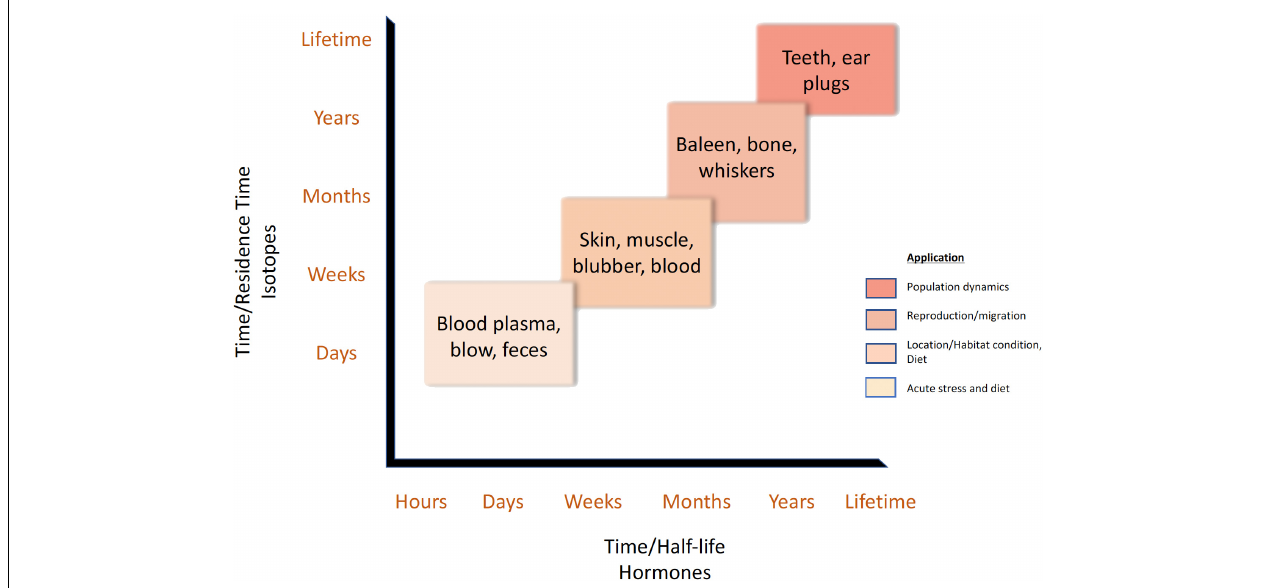
FIGURE 2 | The retention times of stable isotopes vary by tissue type as isotopic incorporation and protein turnover rates differ among tissues (Kurle, 2009). Similarly, the half-life of hormones varies across tissue type depending on each individual hormone and the matrices’ chemical characteristics. This schematic illustrates the temporal scales captured by isotope or hormone analyses of multiple tissue types and some potential ecological applications of both stable isotope and hormone analyses matched to these time scales. As noted in the text, these temporal scales may vary across taxa (e.g., mammal bone vs. turtle